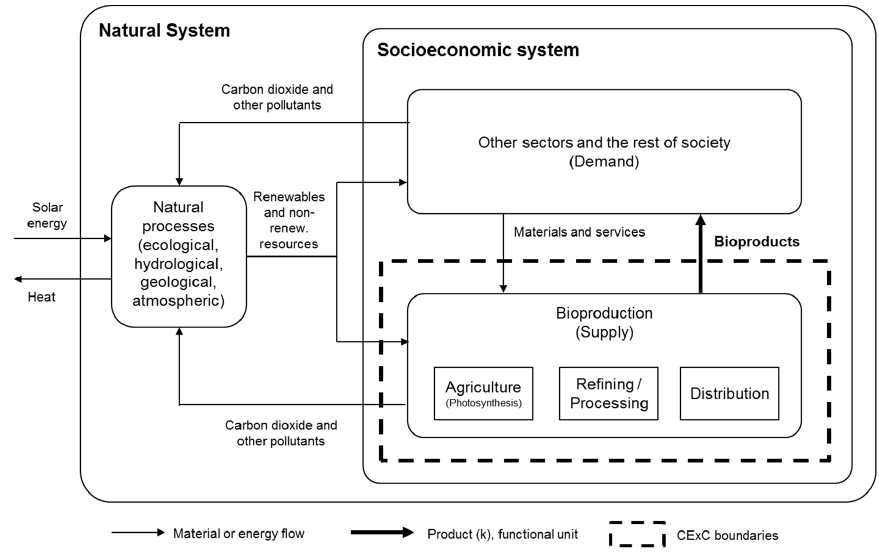
Figure 4. System definition for the LCA/ CExC of bioproducts.